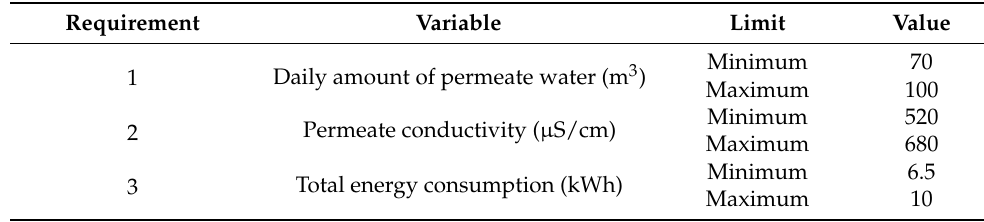
Table 3. Requirements applied to the initial dataset based on the needs of a marine vessel. Requirement Variable